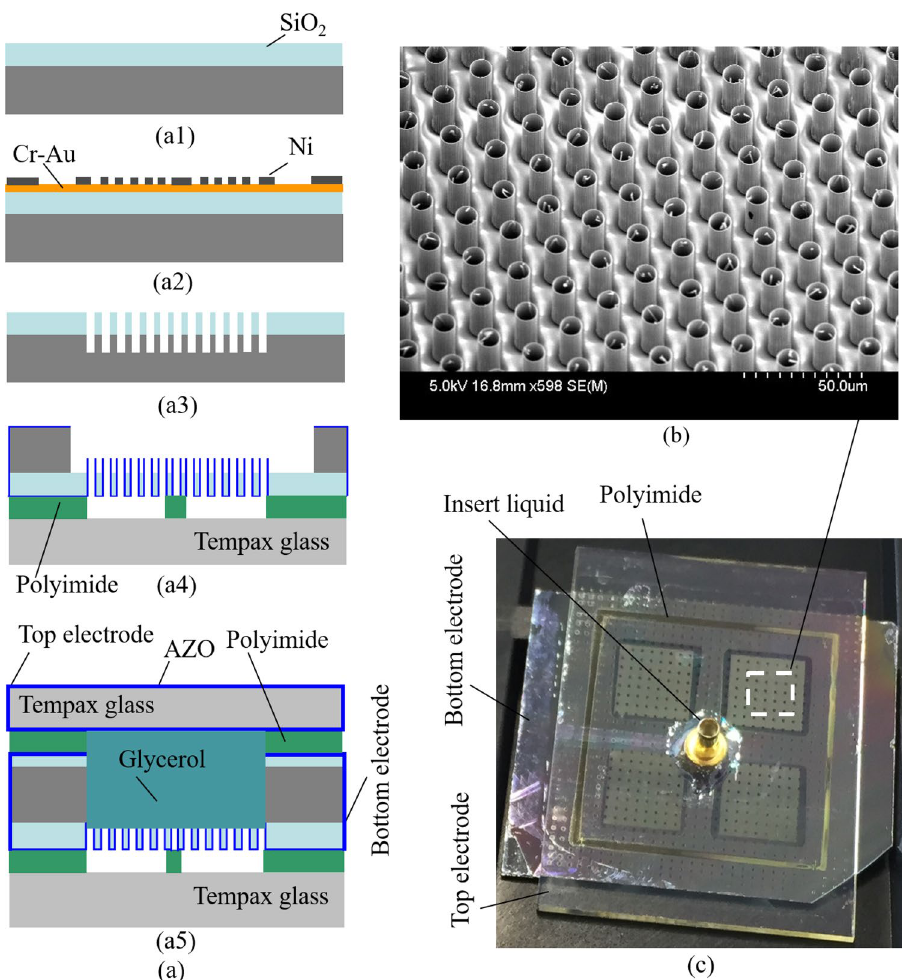
Figure 5. Optical modulator. ( a ) Fabrication process. ( a1 ) Thick SiO 2 deposition on a silicon wafer by PECVD. ( a2 ) Ni electroplating. ( a3 ) Etched SiO 2 by reactive ion etching. ( a4 ) Transferring process to a glass substrate with polyimide pillars. ( a5 ) Bonding with the liquid reservoir. ( b ) Fabricated AZO capillaries. ( c ) Completely fabricated